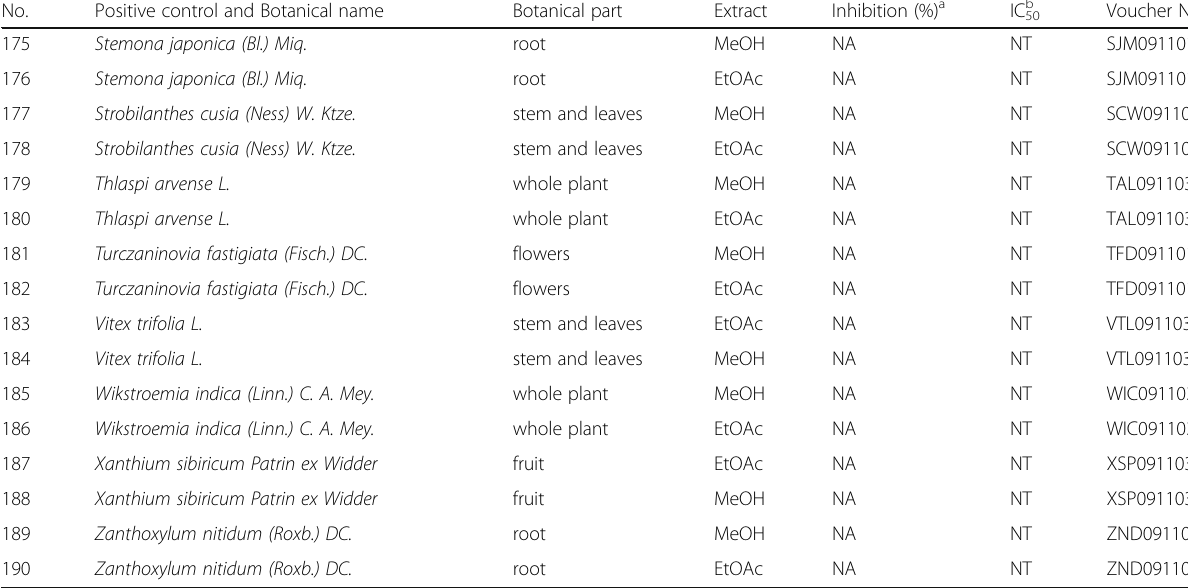
Table 1 Inhibitory activities of Chinese herbs extract on A(H1N1) influenza virus neuraminidase (Continued) No.